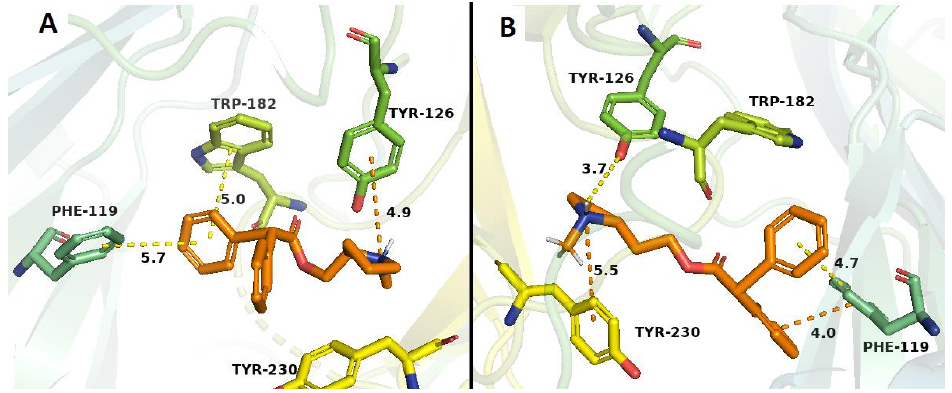
Figure 7. Binding modes of compound 20 ( A ) and compound 21 ( B ) to the human α4β2 nAChR. The orange-ligands denotes compounds 20 and 21. Dotted lines correspond to the different interactions which may take place in the ligand – receptor complexes.